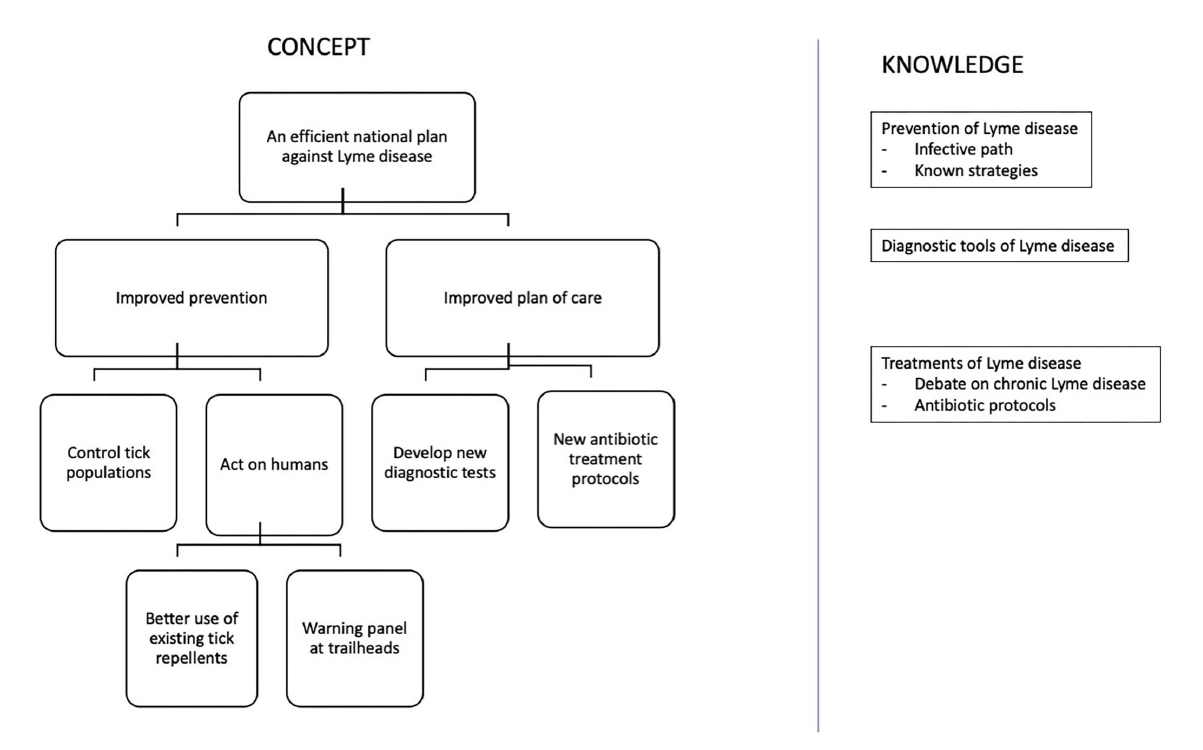
FIGURE2 CK diagram of the government plan against Lyme disease